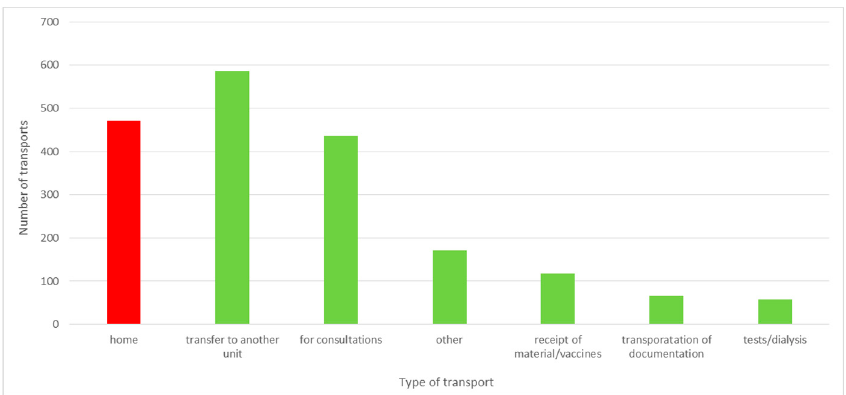
Figure 12. The number of transports ordered by the hospital in the second half of 2019. Source: own study based on hospital data.